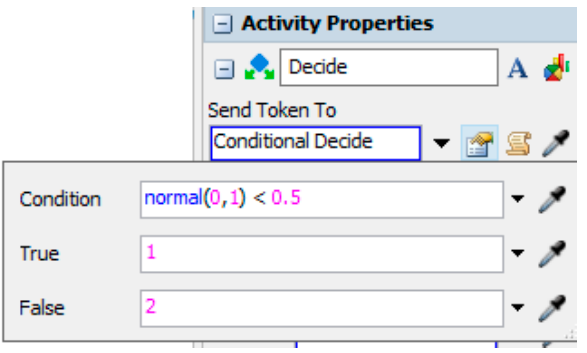
Figure 9. Example of a probabilistic decision with FlexSim.